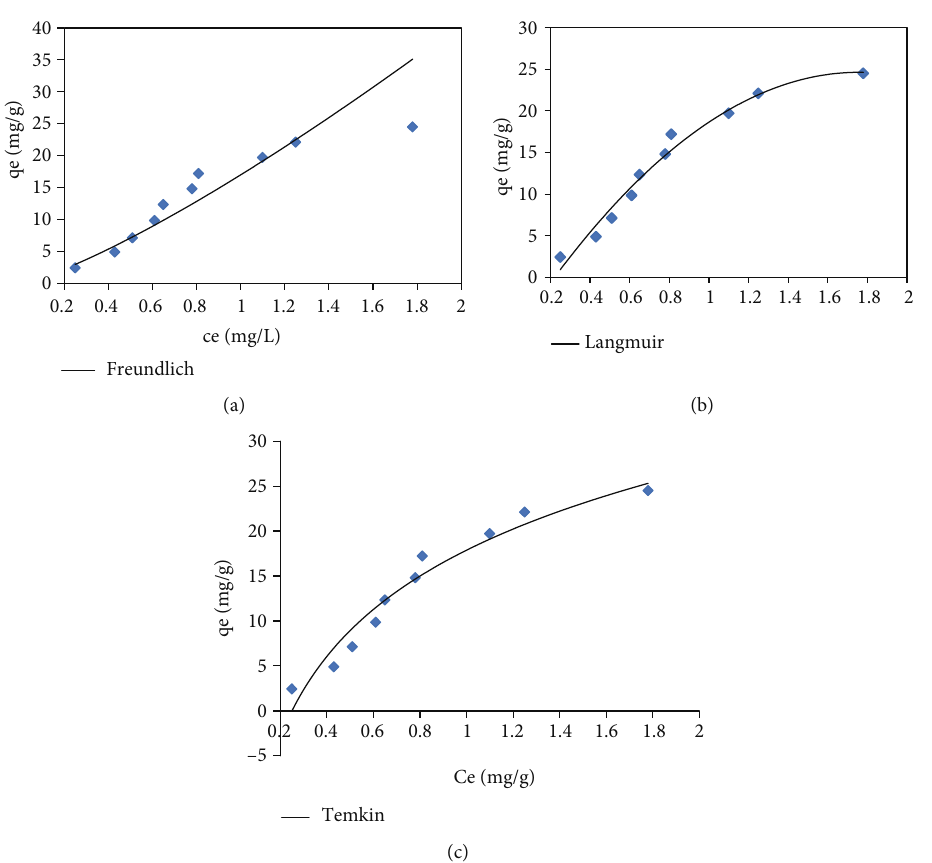
Figure 8: (a) Freundlich isotherm plot; (b) Langmuir isotherm plot for the adsorption of methylene blue onto Neolamarckia cadamba leaves; (c) Temkin isotherm plot for the adsorption of methylene blue onto Neolamarckia cadamba leaves. Table 5: Adsorption isotherm for the removal of methylene blue on Neolamarckia cadamba